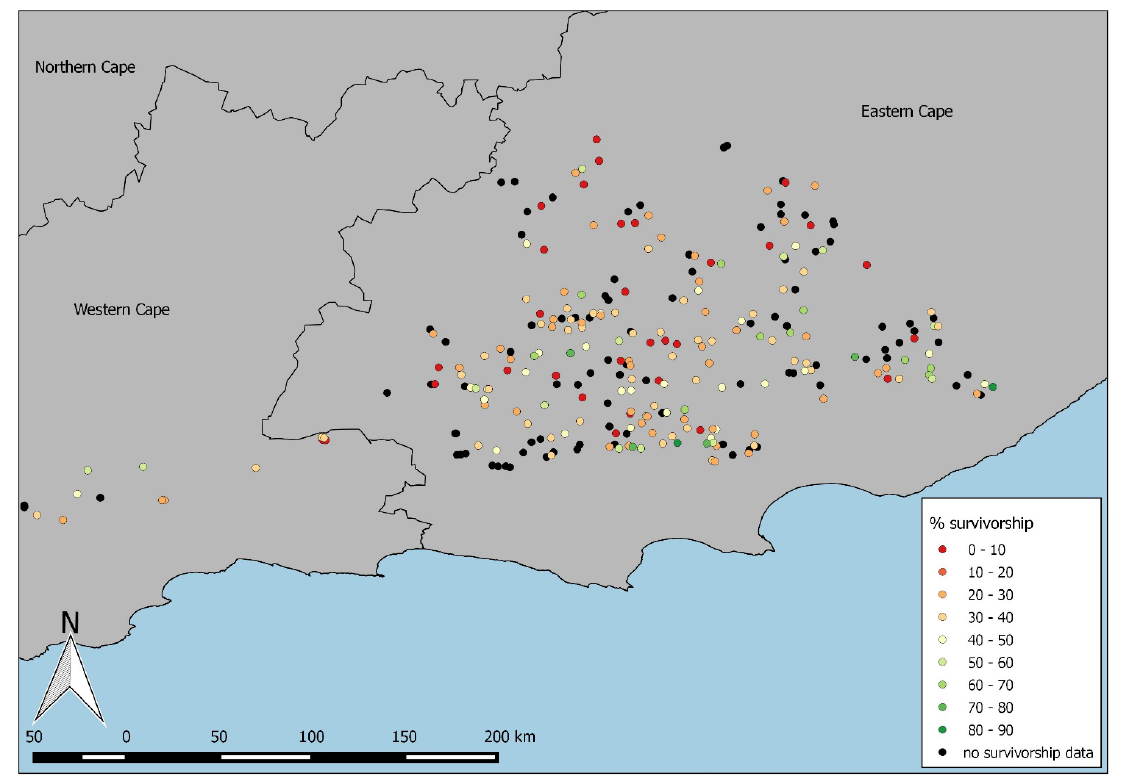
Figure 4. Location of the 331 plots within the large-scale restoration experiment conducted by the STRP in the Eastern Cape and Western Cape, South Africa. Different colours of circles denote average survivorship across all treatments in individual